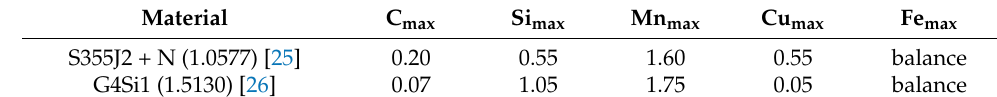
Table 1. Chemical composition of materials used.